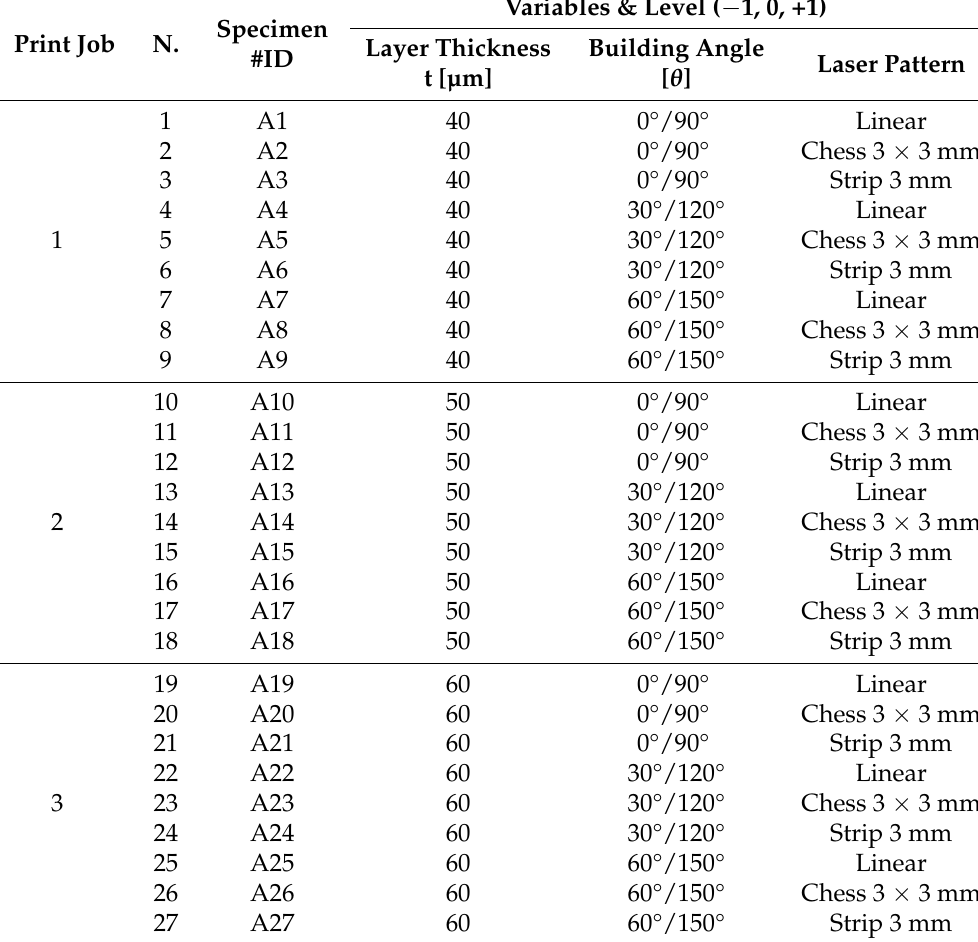
Table 2. Full Factorial design of experiment (DOE) of the SLM process